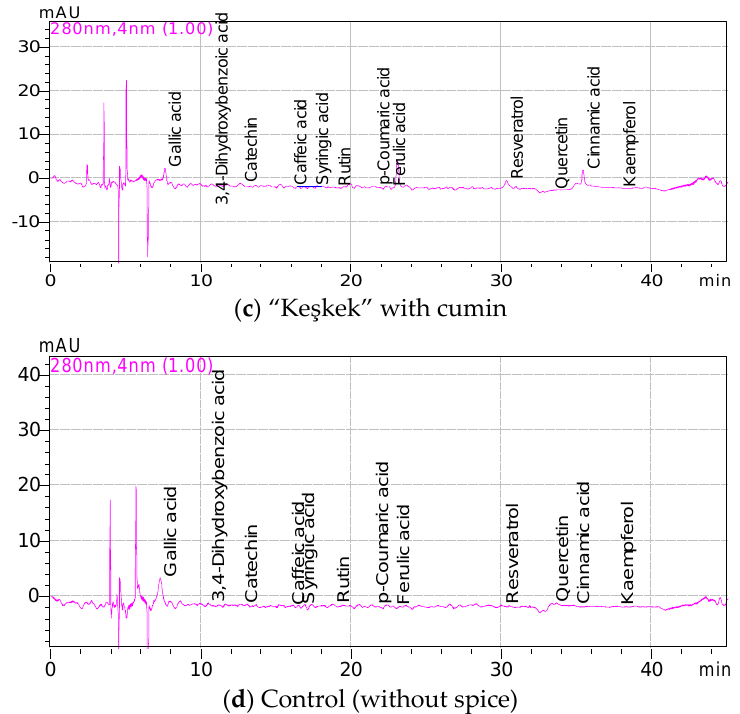
Figure 1. Phenolic chromatograms of control and “Keşkek” samples ( a – d ) with spice added.